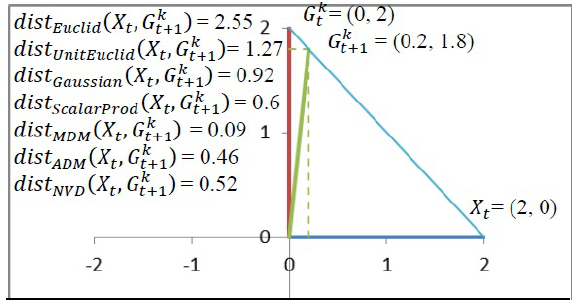
Figure 5: Comparison of distance values after a Kohonen update (Equation 27) with λ = 0.1. Comparing Fig. 5 to Fig. 4 we see that )︀ > dist (︀ X )︀ using this update. All , G k dist NVD (︀ X t , G k t NVD t t +1